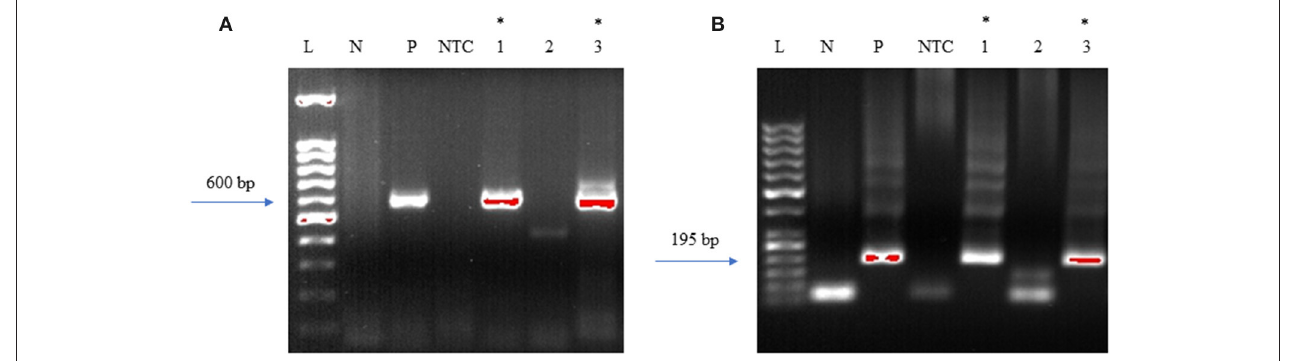
FIGURE 11 | Primers amplify Borrelia 16S − 23S internal transcribed spacer (ITS) region. Bobu primers generate an amplicon size of 600 bp. To increase the specificity Bobu internal primers were designed to generate an amplicon size of 195 bp. (A) External PCR: L-molecular weight marker of 100 bp, N-negative control, P-positive control, NTC-No Template Control, 1–12,577 amygdala, 2–12,577 pons, 3–12,577 spinal cord. (B) Internal PCR: L-molecular weight marker of 50 bp, N-negative control, P-positive control, NTC-No Template Control, 1–12,577 amygdala, 2–12,577 pons, 3–12,577 spinal cord. *Samples that were positive to Borrelial